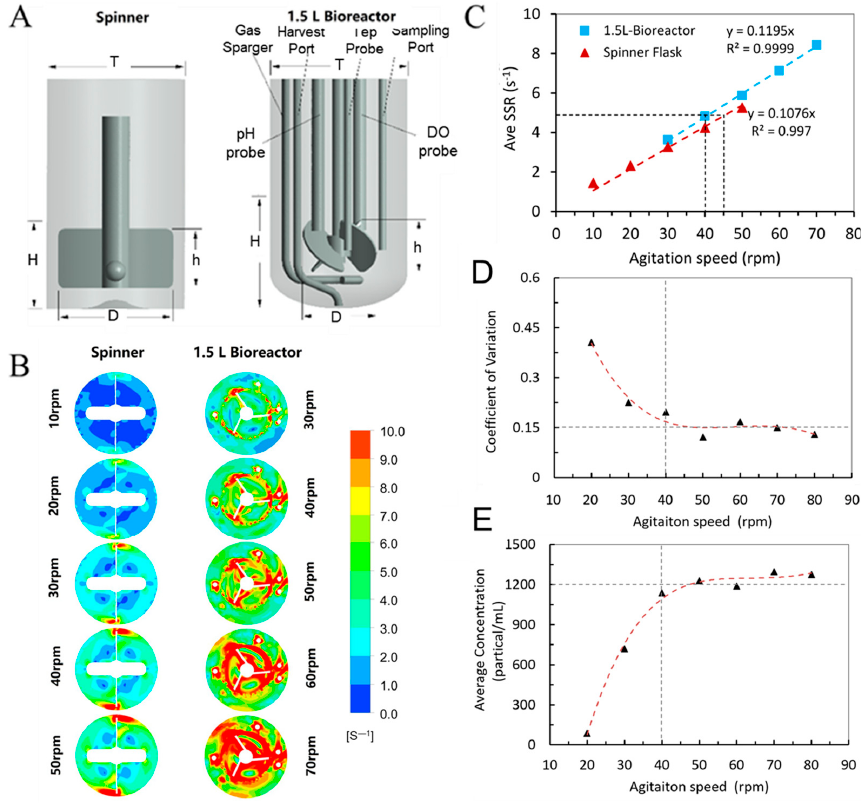
Figure 3. ( A ) Geometry of the spinner flask and BioStar 1.5c. ( B ) Horizontal slice contour plots of the shear strain rate in the spinner flask and BioStar 1.5c. ( C ) Volume-averaged shear strain rate relationship between the BioStar 1.5c and spinner flask to determine an appropriate scale-up value. ( D , E ) Coefficient of variation and average concentration of the microcarrier density in BioStar 1.5c, the triangles mean a value calculated by CFD andthe dashed line represent the fitted curve.